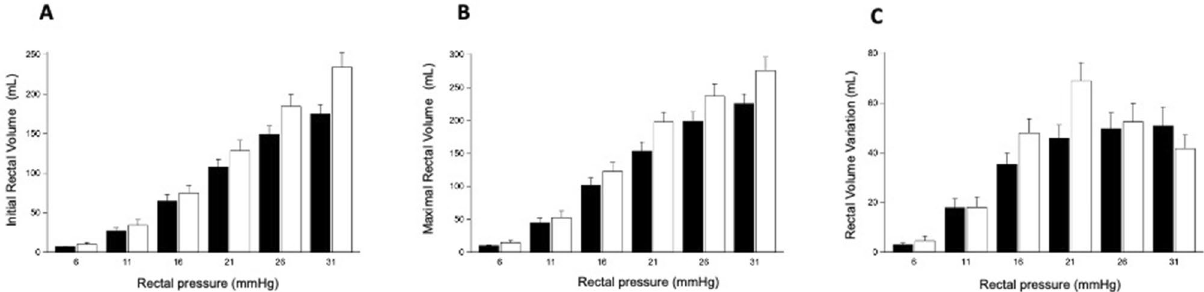
Figure 1. Rectal adaptation to isobaric distension. ( A ) Increasing the pressure of distension increased the recorded initial rectal volume (pressure effect, p < 0.0001). Compared with the HVs, the recorded initial rectal volumes (rectal compliance) were significantly lower in the patients with SB (group effect, p = 0.01; interaction group pression, p = 0.04). ( B ) Increasing the pressure of distension increased the recorded maximal rectal volumes (pressure effect, p < 0.0001). ( C ) Increasing pressure of distension decreased the rectal tone (maximal volume–initial volume) up to the treshold of 21 mmHg (pressure effect, p < 0.0001) for both groups. Compared with the HVs, rectal tone was significantly higher in the patients with SB up to the treshold of 21 mmHg (group effect, p = 0.08; interaction group pression; p = 0.001). *Patients with Spina Bifida; O Healthy